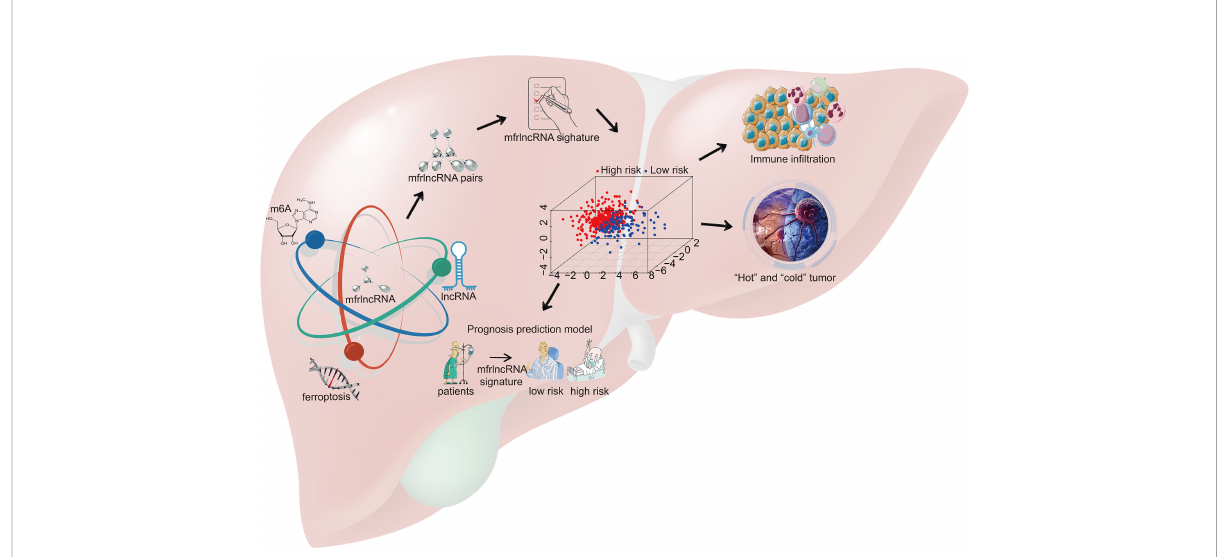
FIGURE 10 Schematic diagram. A group of speci fi c lncRNAs associated with both m6A regulators and ferroptosis-related genes was identi fi ed using correlation analysis and named m6A- and ferroptosis-related lncRNA (mfrlncRNA). The mfrlncRNA signature was constructed based on mfrlncRNA pairs and patients were strati fi ed into high- and low-risk populations. Through further exploration, the prognostic value of the mfrlncRNA signature was evaluated as well as immune in fi ltration, immune ef fi cacy, and drug